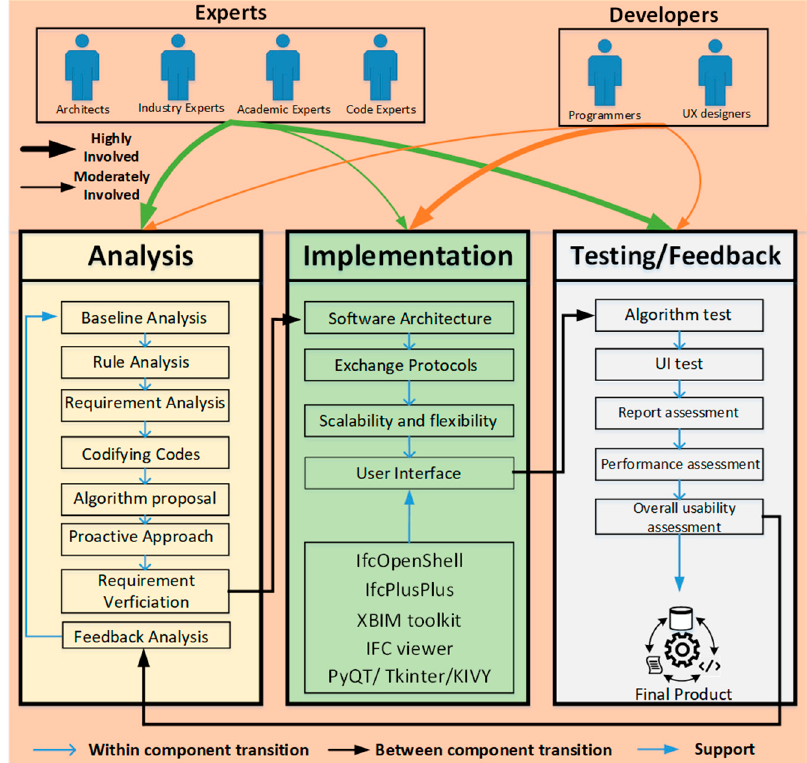
Figure 2. The proposed framework for developing proactive ARC systems.